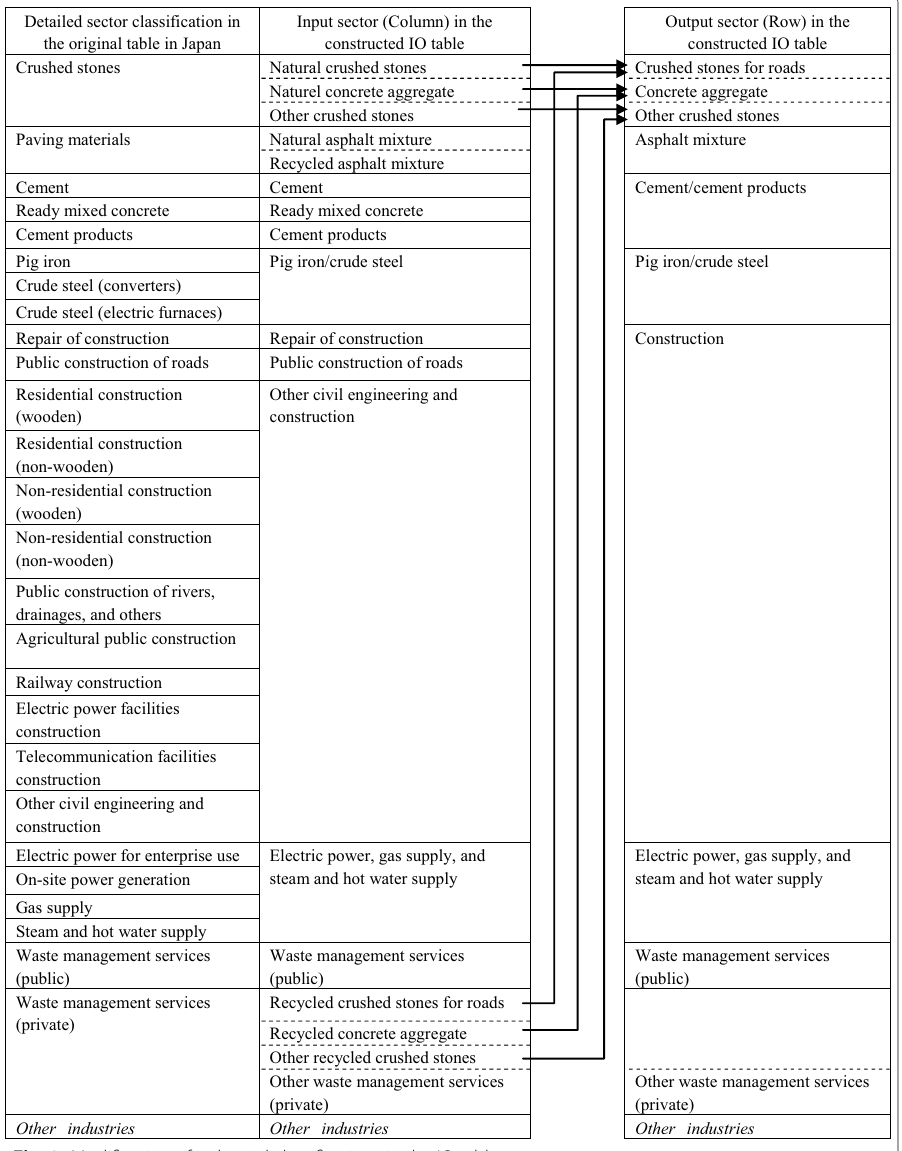
Fig. 2 Modification of industrial classifications in the IO table